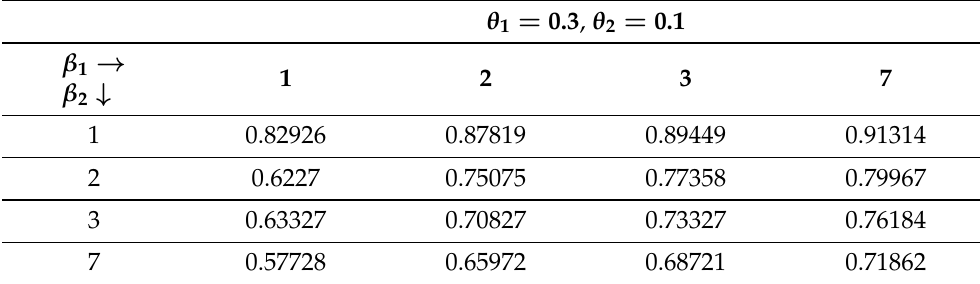
Table 3. Numerical values of Re Stress − Strength associated with the DPsL distribution at θ 1 = 0.3, θ 2 = 0.1 for different values of β 1 and β 2